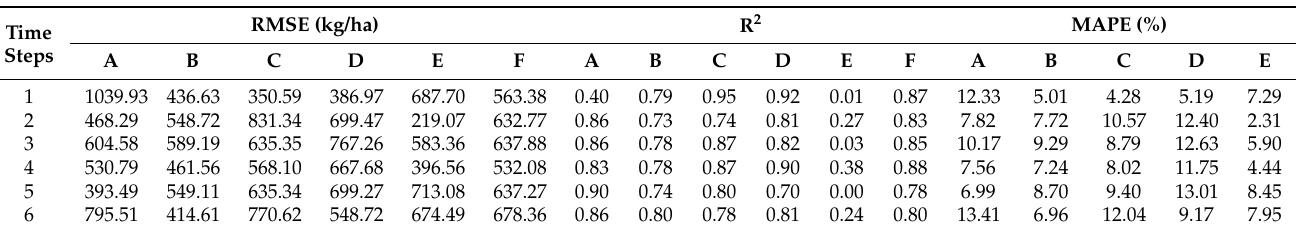
Table 1. The accuracy evaluation of the LSTM prediction model was compared between different time steps when 12 LAI data were input.